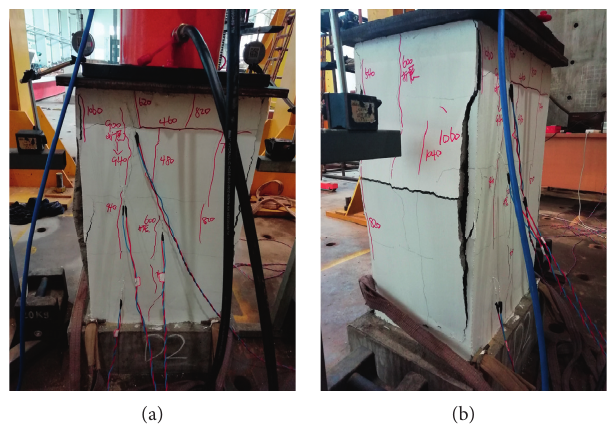
Figure 9: Typical failure of group ZD.